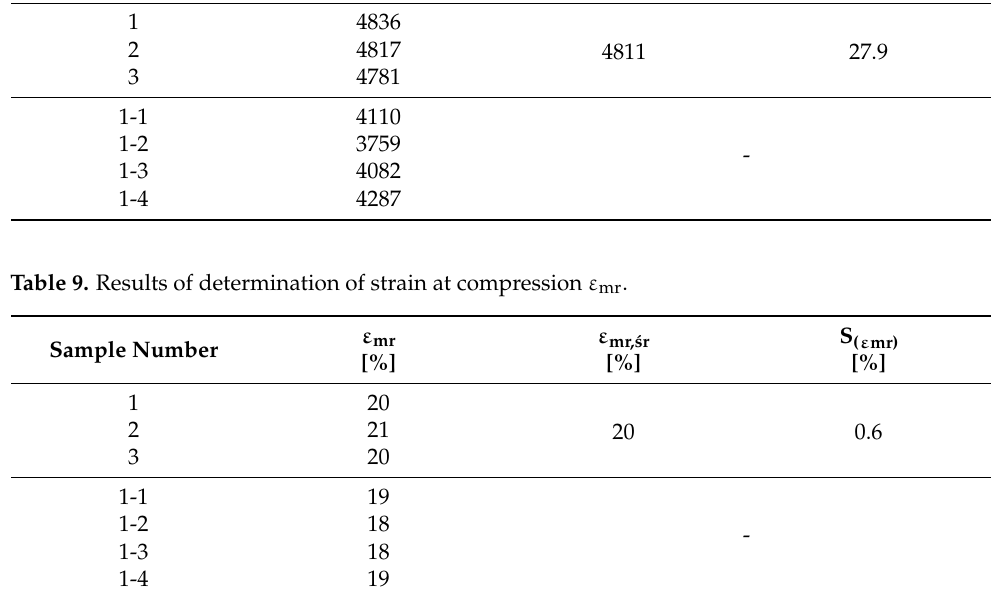
Table 8. Results of determination of compressive strength σ mr .